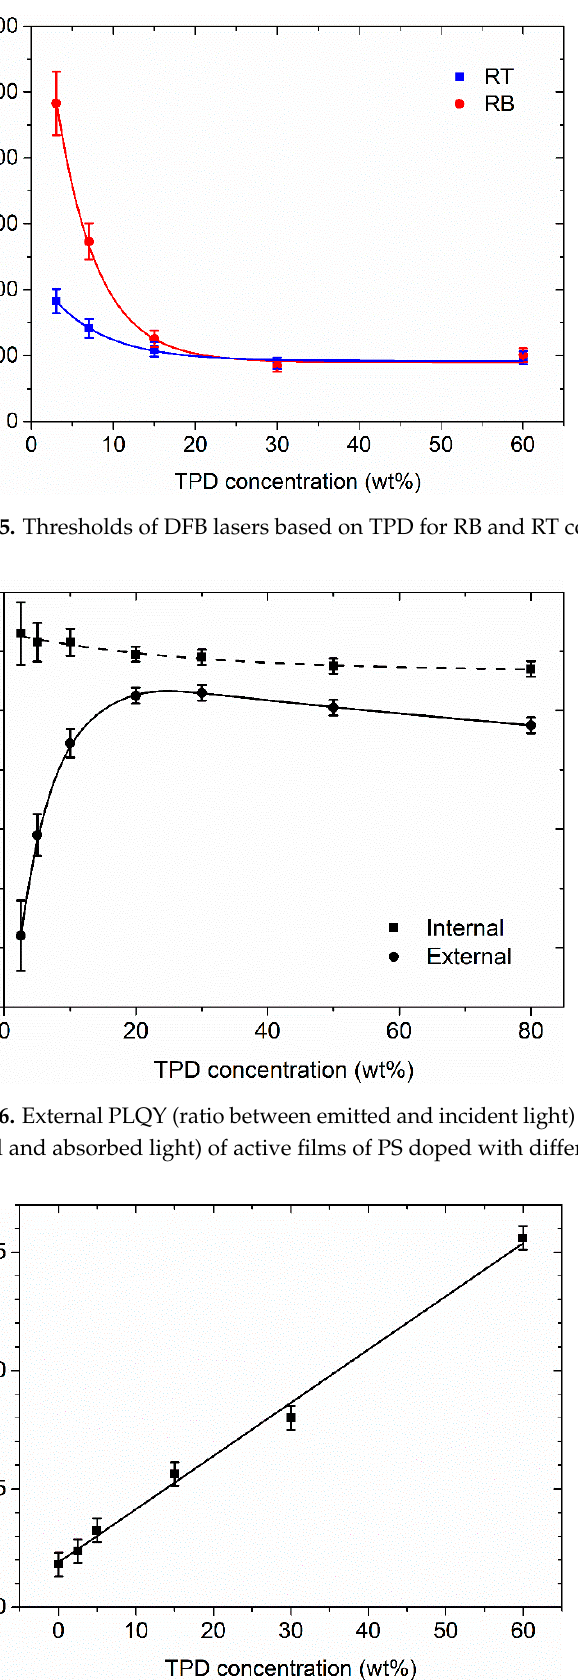
Figure 7. Refractive index of active films of PS doped with different concentrations of TPD.